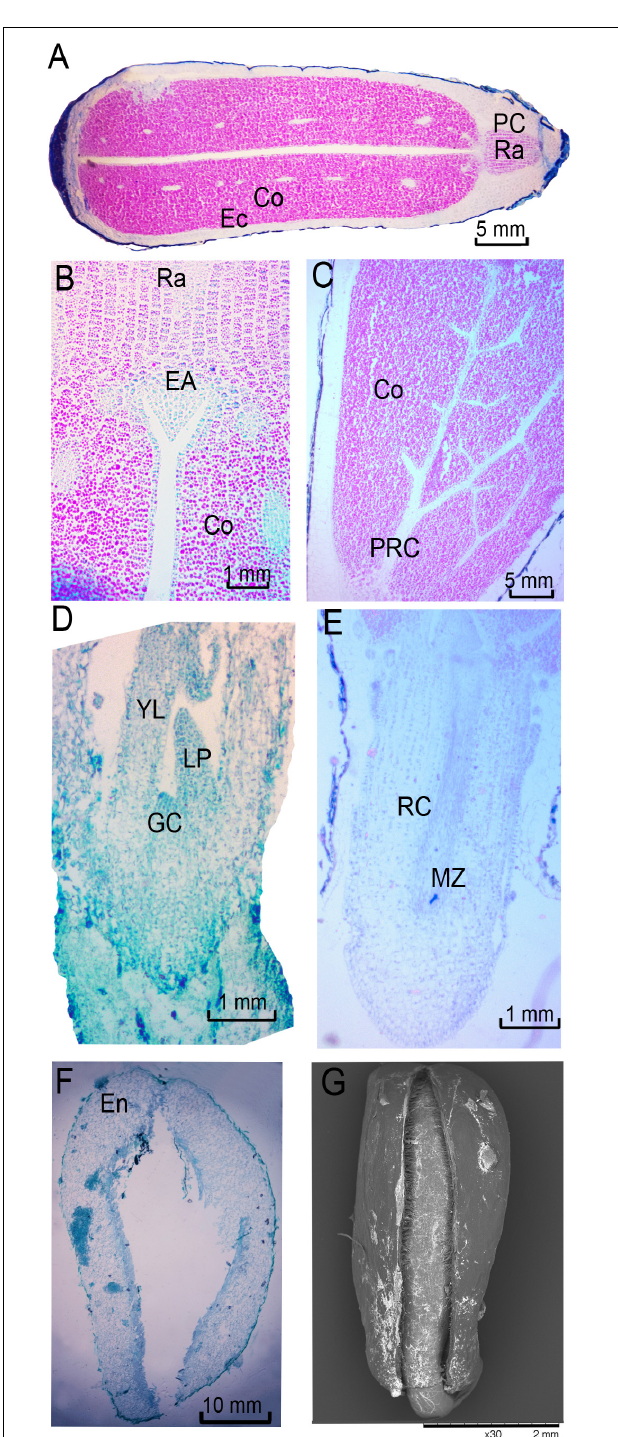
FIGURE 5 | Anatomy of Rosa rugosa seeds after released from dormancy. (A) Exalbuminous seed with dicotyledon. (B) Triangular plumule primordium. (C) Protocambium. Developing plumule (D) and primary root (E) . (F,G) Endocarp after radicle breakthrough. EN, endocarp; CO, cotyledon; EC, ectocarp; RA, radicle; PC, parenchyma cells; EA, embryonic axis; GC, growth cone; PRC, protocambium; LP, leaf primordium; YL, young leaf; RC, root cap; MZ, meristem